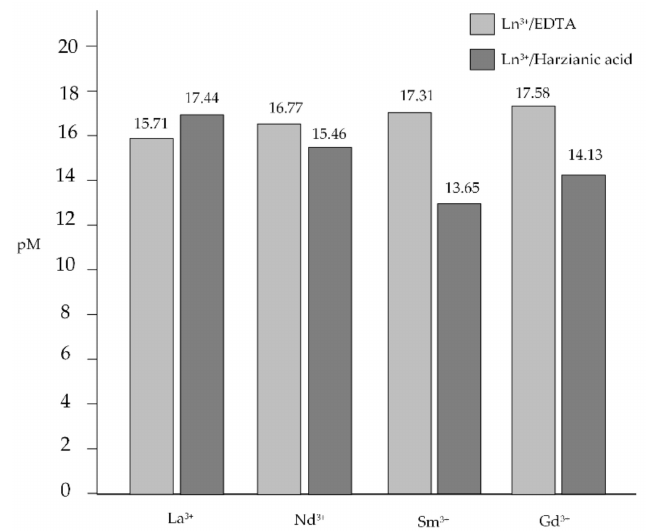
Figure 6. pM values calculated for La 3+ –harzianic acid, Nd 3+ –harzianic acid, Sm 3+ –harzianic acid, and Gd 3+ –harzianic acid systems using equilibrium constants determined in this paper in the CH 3 OH/0.1 M NaClO 4 (50/50 w/w ) solvent. pM values for Ln 3+ –EDTA systems are used for broad comparison purposes since EDTA is one of the most popular and powerful chelating